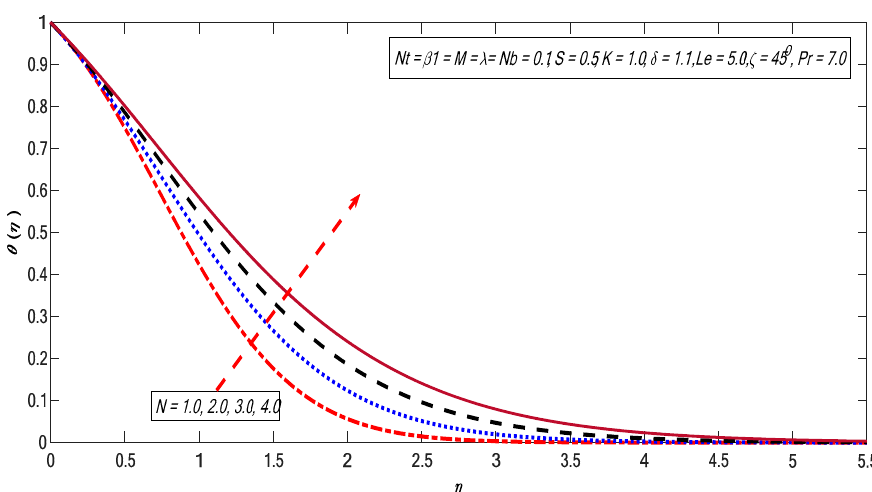
Figure 14. Variations in temperature profile for several values of 𝑁 .